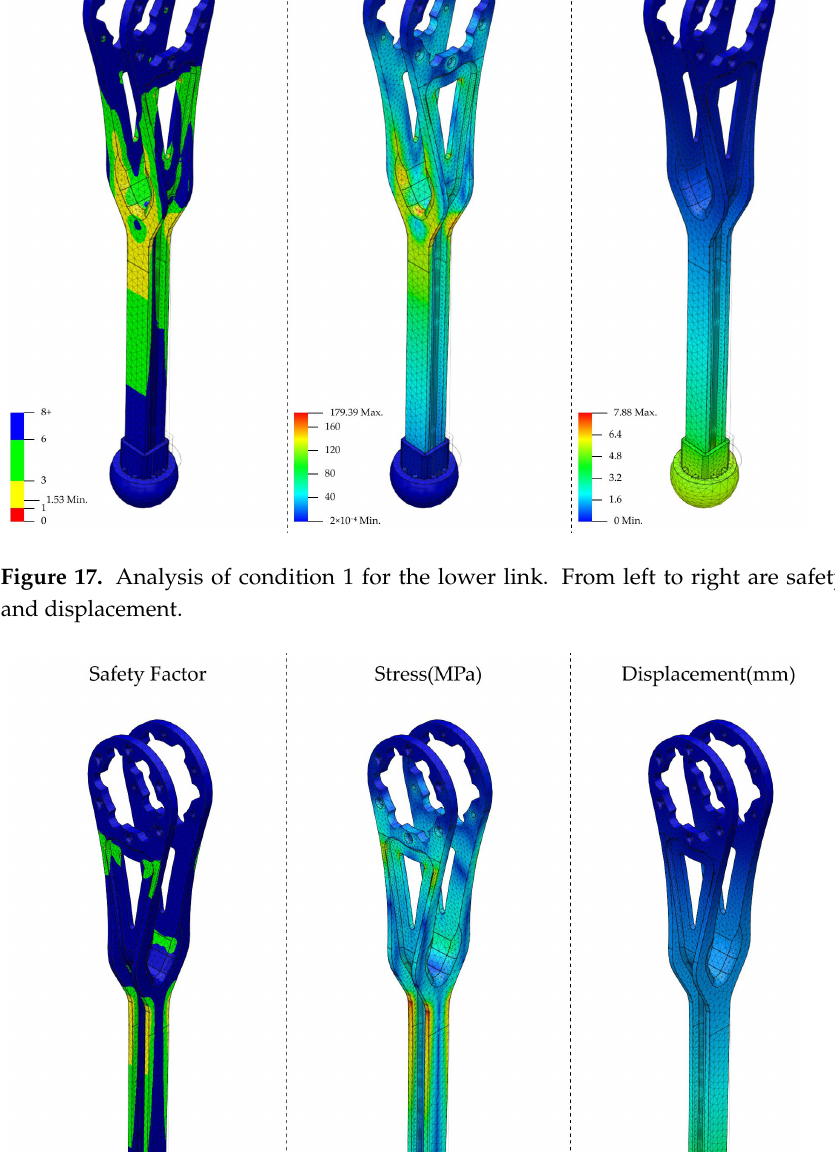
Figure 18. Analysis of condition 2 for lower link . From left to right are safety factor, stress, and displacement. and